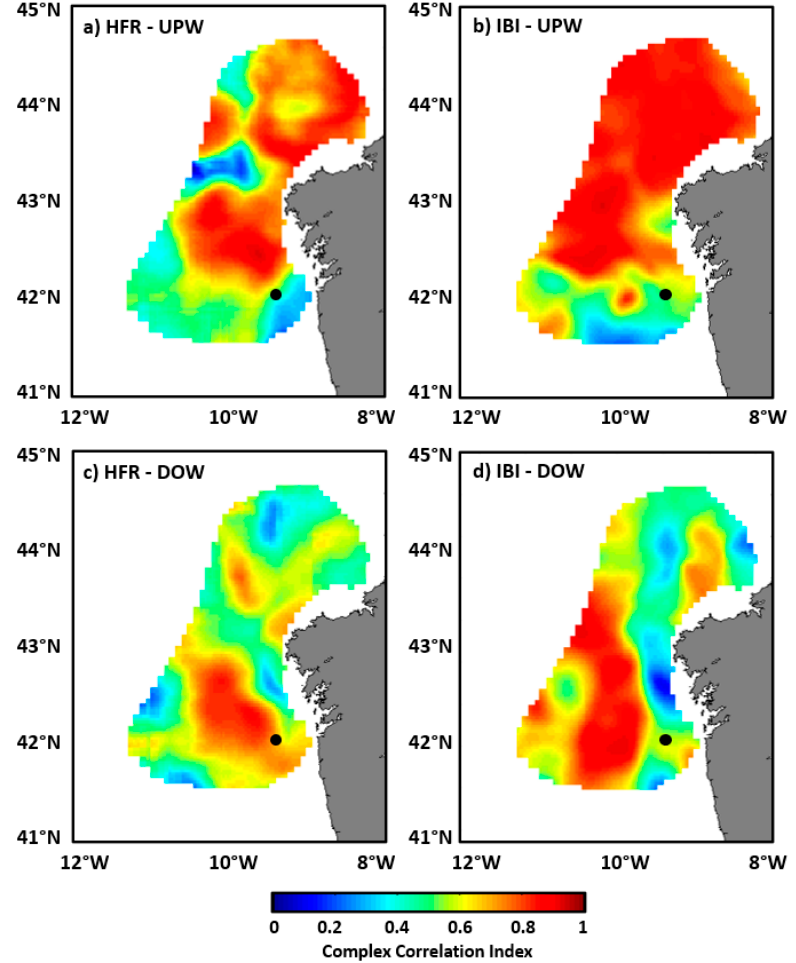
Figure 7. Maps of complex correlation (CC) index between low-pass filtered hourly wind at B1 buoy and subtidal surface currents provided by the HFR ( a , c ) and IBI model ( b , d ), under upwelling (UPW, a , b ) and downwelling (DOW, c , d ) conditions. Black dot represents B1 buoy. Complementarily, the time-lagged CC investigation between subtidal currents and low-pass filtered wind time series (not shown) revealed the timely response of the upper layer flow, observed and modelled, to prevalent wind forcing. As expected, a peak of correlation (above 0.8) was generally detected during the first four hours and later accompanied by a gradual decrease in CC coefficient,